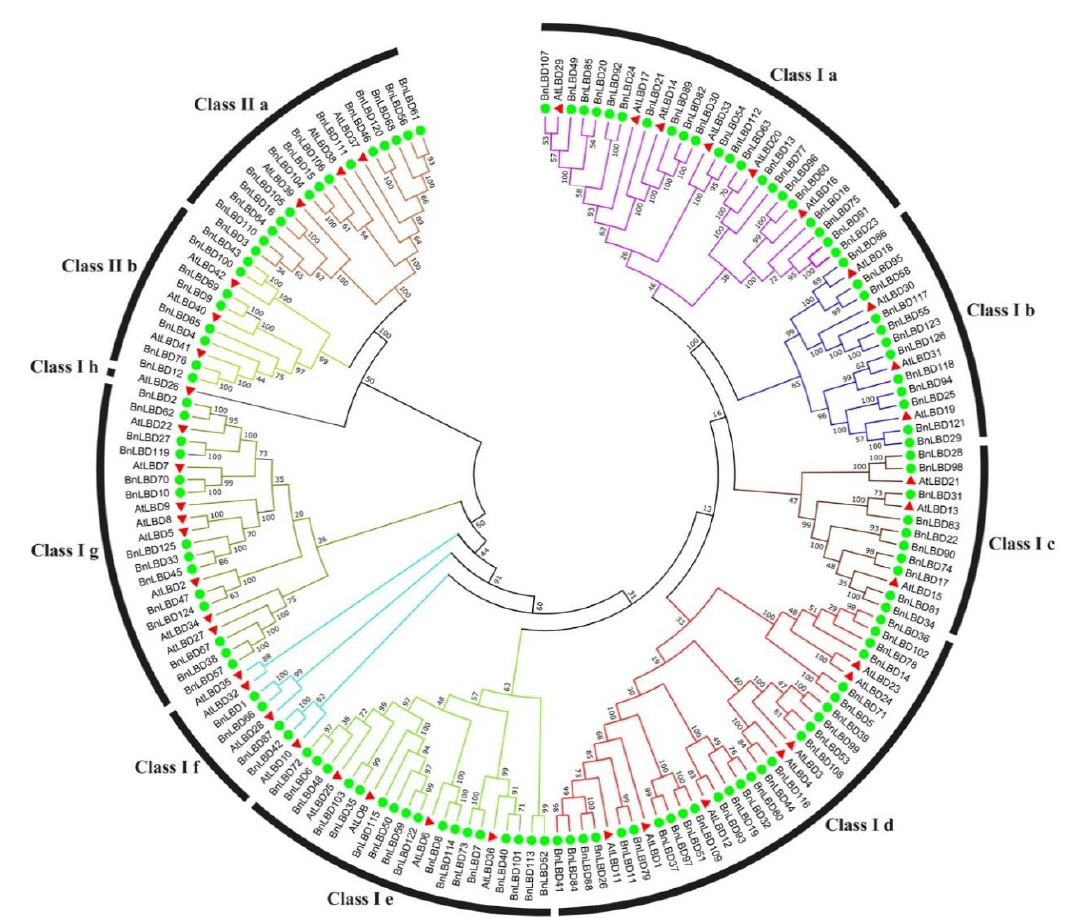
Figure 3. Phylogenetic relationship of LBD proteins in B. napus and A. thaliana . The di ff erent colors indicate di ff erent subgroups of the LBD family. The green circles and red triangle represent LBDs from B. napus and A. thaliana , respectively. The numbers on the branches indicate the reliability percent of bootstraps value based on 1000 replications.